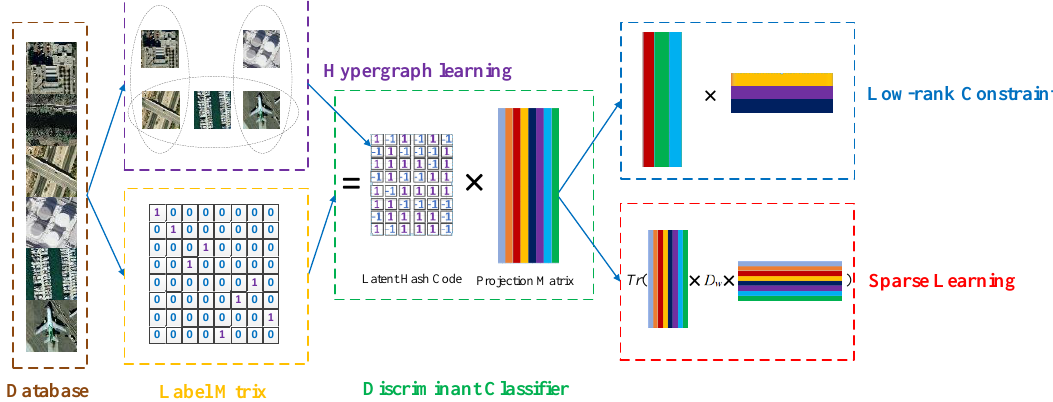
Figure 1. Illustration of the proposed low-rank hypergraph hashing (LHH).